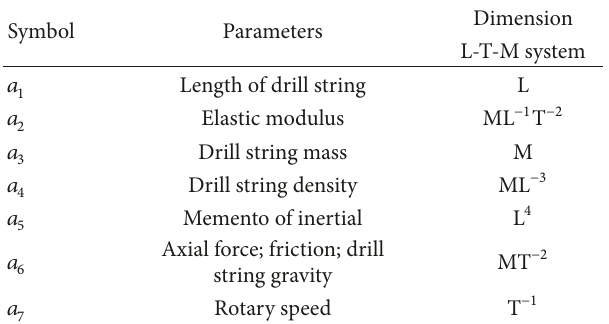
Table 1: Drill string dynamics affect parameters and